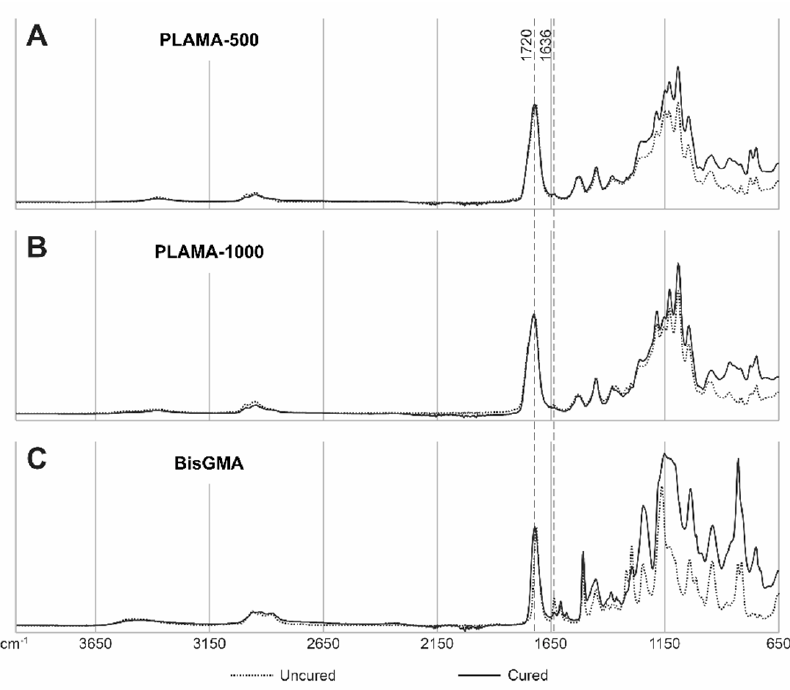
Figure 3. Examples of IR spectra for uncured and cured (on day 28) materials: PLAMA-500 ( A ), PLAMA-1000 ( B ), bisGMA ( C ). The curves are normalized at wavenumbers 4000 and 1720 cm − 1 .